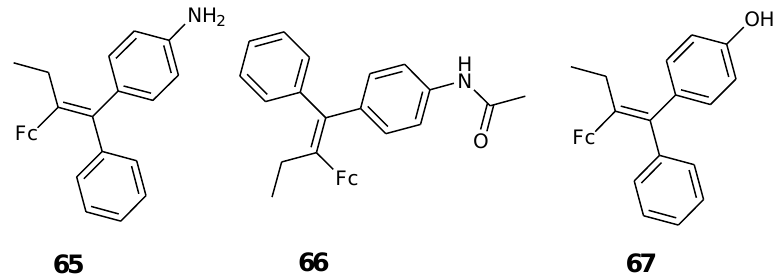
Figure 22. Chemical structures of 2-ferrocenyl-1-1-diphenyl-but-1-ene derivatives ( 65 – 67 ).